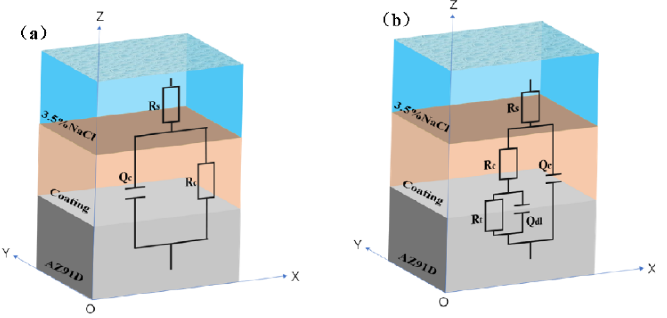
Figure 8. Equivalent circuits of coating/magnesium alloy systems (Models A and B).